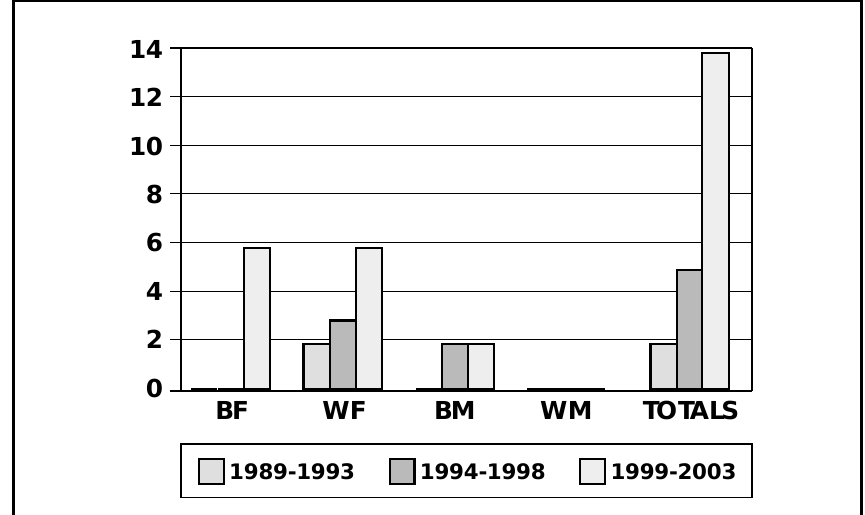
Figure 1: Changes in author demographics over the three five-year periods.